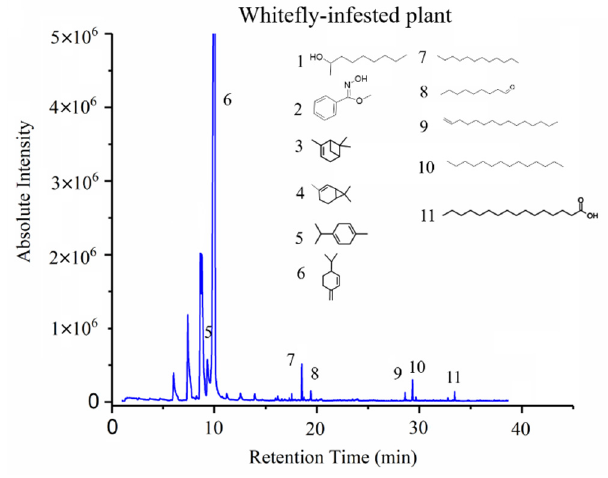
Figure 6. A typical GC-MS spectrum of VOCs from healthy tomato plant.